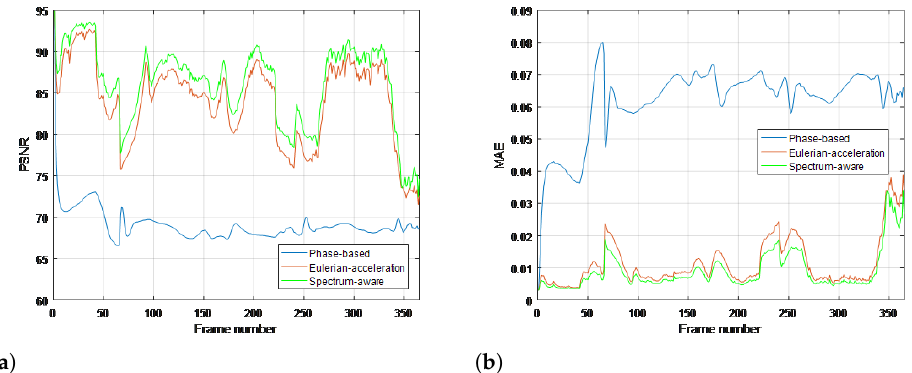
Figure 11. Objective metrics with ground truth for each magnification processing using ( a ) PSNR and ( b ) MAE in eye video.